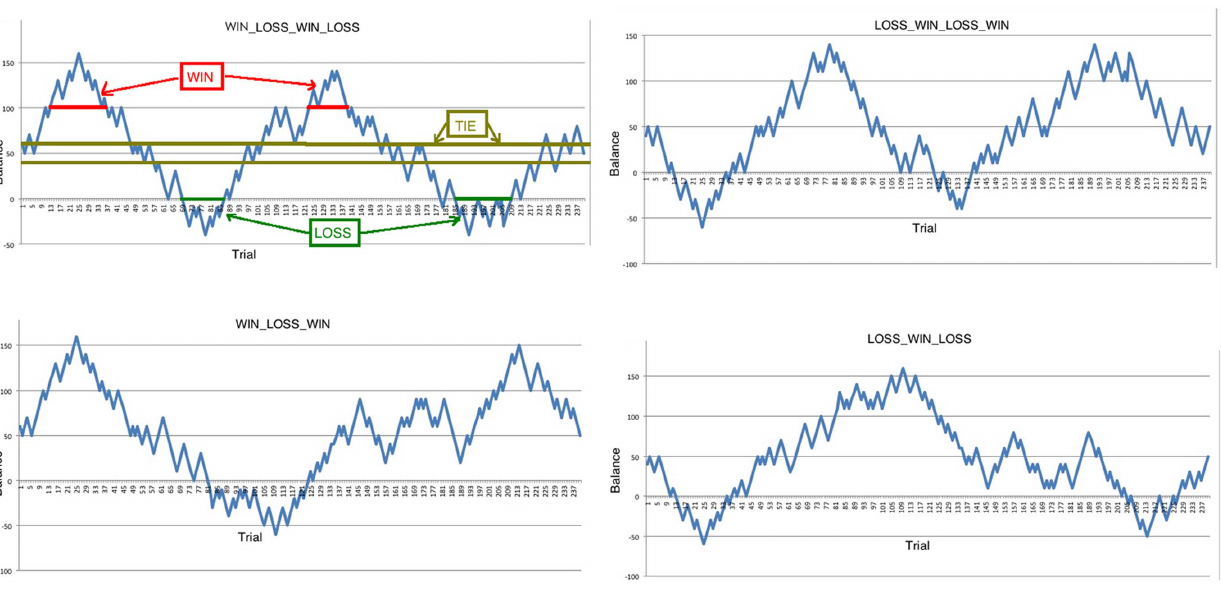
Figure 2. The figure shows the changes of the whole balance in this study. Participants’ balance will waved in one of the four situations (WIN-LOSS-WIN-LOSS; WIN-LOSS-LOSS-WIN; LOSS-WIN-LOSS-WIN;